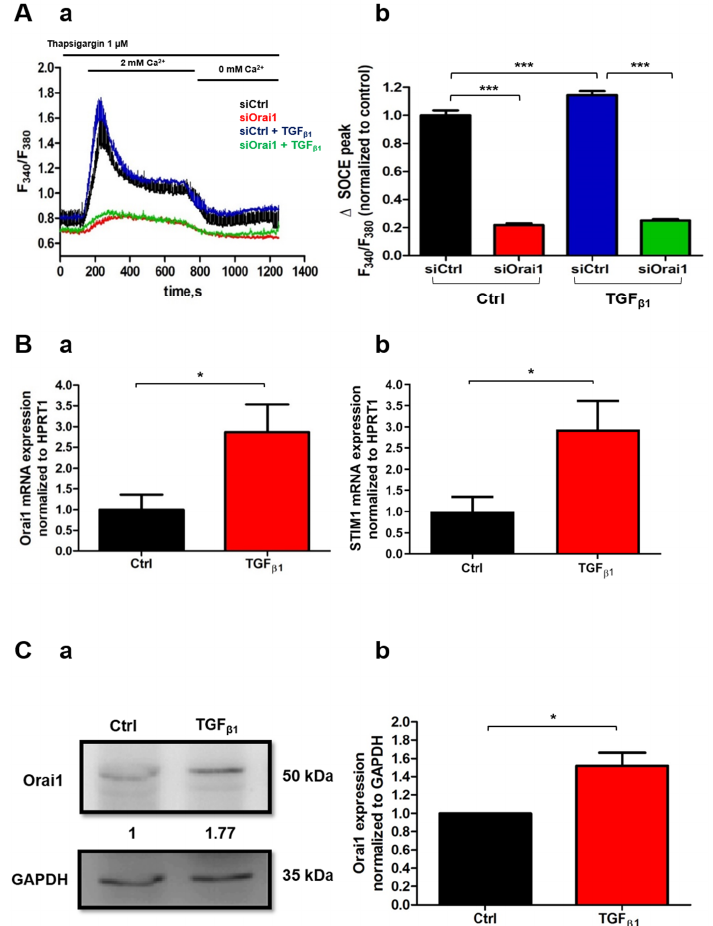
Figure 5. TGF β 1 enhances Orai1-mediated Ca 2+ entry and increases both Orai1 mRNA and protein expression. ( A ) TGF β 1 (5 ng/mL) perfusion was applied to investigate the effect of TGF β 1 on Orai1 activity. siCtrl and siOrai1 72 h-transfected cells were pre-treated for 5 min with 1 µ M of Thapsigargin before use for SOCE measurements in Ca 2+ - imaging. Illustrative traces of SOCE measurements ( Aa ) and the quantification of perfused and non-perfused siCtrl and siOrai1 transfected cells (siCtrl: n = 133, siCtrl + TGF β 1 : n = 163, siOrai1: n = 102, siOrai1 + TGF β 1 : n = 122, N = 3, *** p < 0.001, one-way ANOVA followed by Bonferroni multiple comparison test, n: number of cells, N: number of passages, ( Ab ). All values were normalized to siCtrl non-treated with TGF β 1 condition and reported as mean ± SEM. ( B , C ) Impact of 48 h TGF β 1 treatment (20 ng/mL) in the presence of low-FBS conditions (1%) on Orai1 and STIM1 ( B ) mRNA and Orai1protein expression ( C ). Quantification of Orai1 ( Ba ) and STIM1 ( Bb ) mRNA transcripts 48 h post-TGF β 1 treatment (* p < 0.05, N = 3, Student t -test) ( B ). Representative Western blot showing the effect of TGF β 1 treatment on Orai1 expression ( Ca ) with the quantification ( Cb ) (* p < 0.05, N = 3, Student t -test). All values were first normalized to the referent protein GAPDH and then to the control condition, reported as mean ±